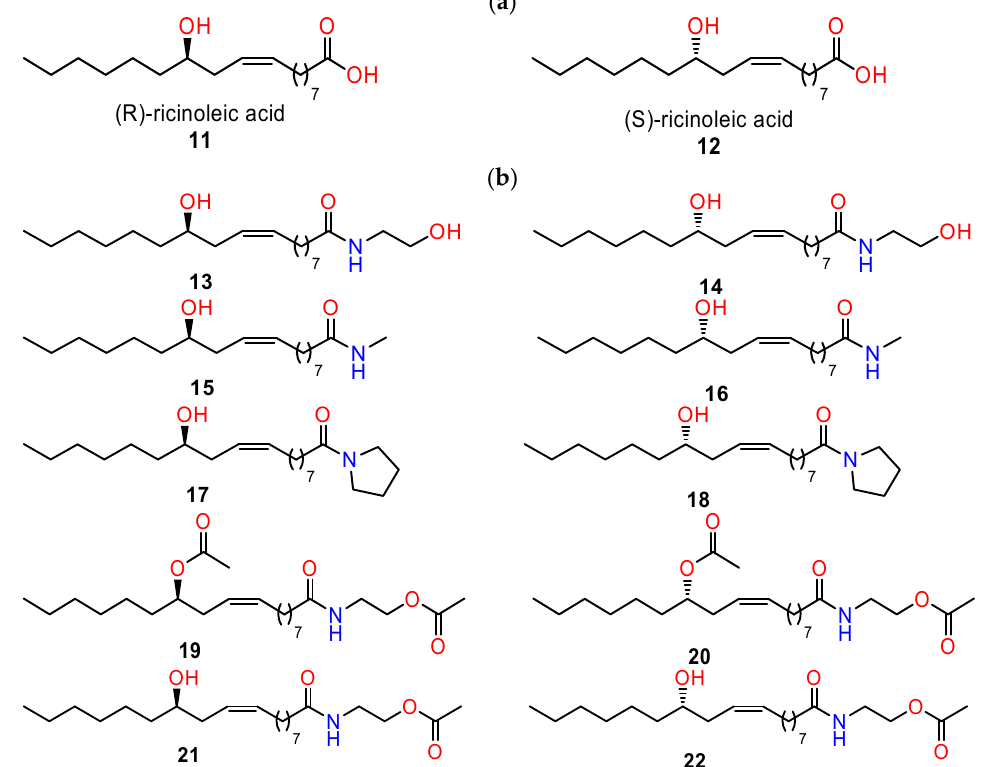
Figure 10. Chemical structures of enantiomeric forms of ricinoleic acid ( a ) and selected chemical derivatives ( b ).